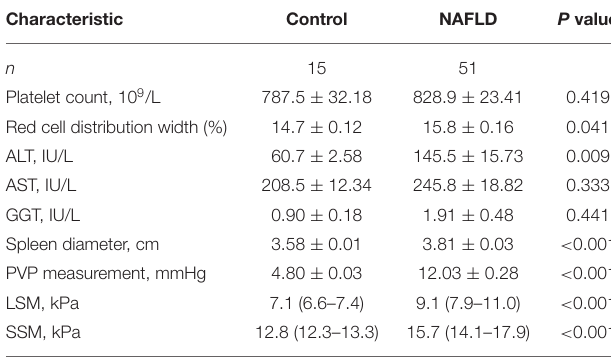
TABLE 1 | Biological, morphological, and elastography characteristics of controls and rats with NAFLD.